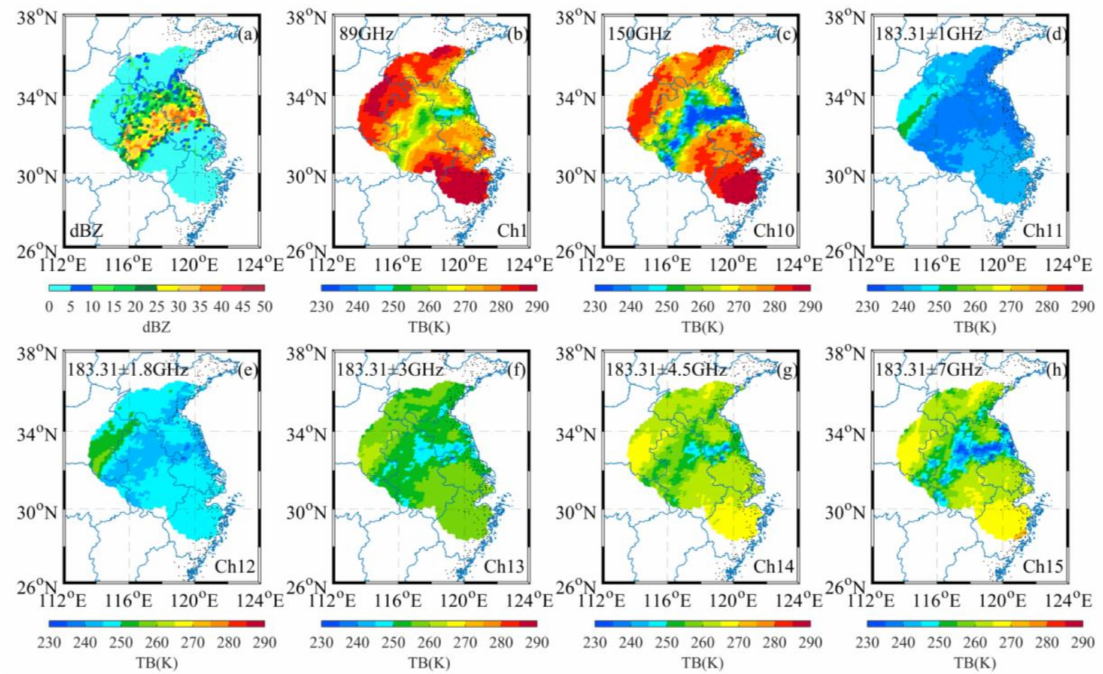
Figure 2. Spatial distribution of ground-based radar reflectivity ( a ) and satellite-observed brightness temperature for window channels ( b – c ) and humidity-sounding channels ( d – h ) on 4 July